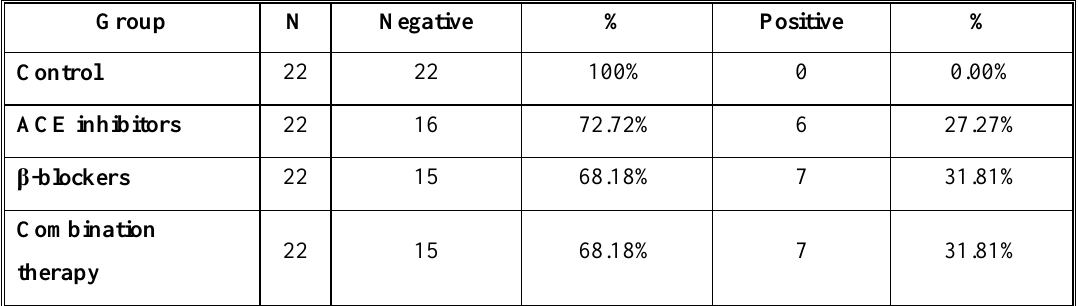
Table 9: C-reactive protein qualitative value in control healthy individuals and hypertensive patients treated with different antihypertensive drug regimens. Each value represents mean± standard error of